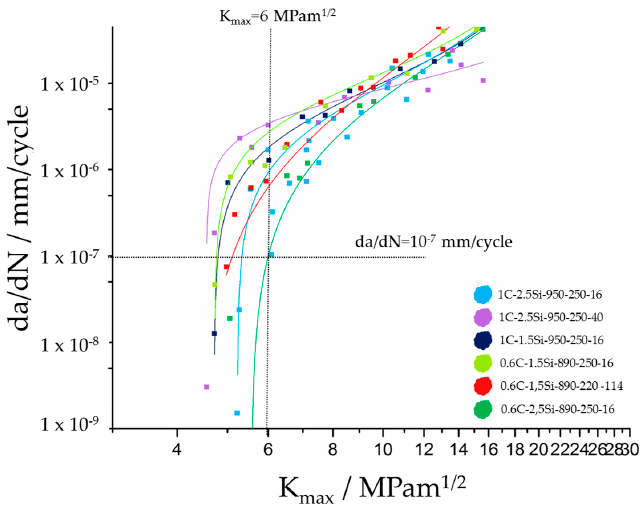
Figure 11. Crack growth curves resulting from crack growth experiments at CT-specimen [19].